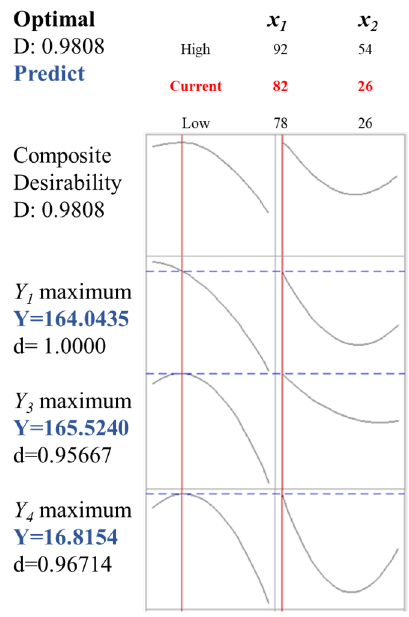
Figure 2. Optimization plot for the responses: Y 1 , DPPH in mg Trolox/100 g; Y 3 , FRAP in mg Fe 2+ /100 g, and Y 4 , total phenolic content in mg GA/100 g.